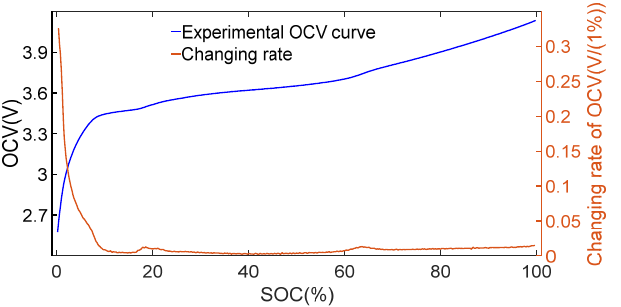
Figure 4. An OCV curve of a NMC battery with changing rate of OCV over SOC.